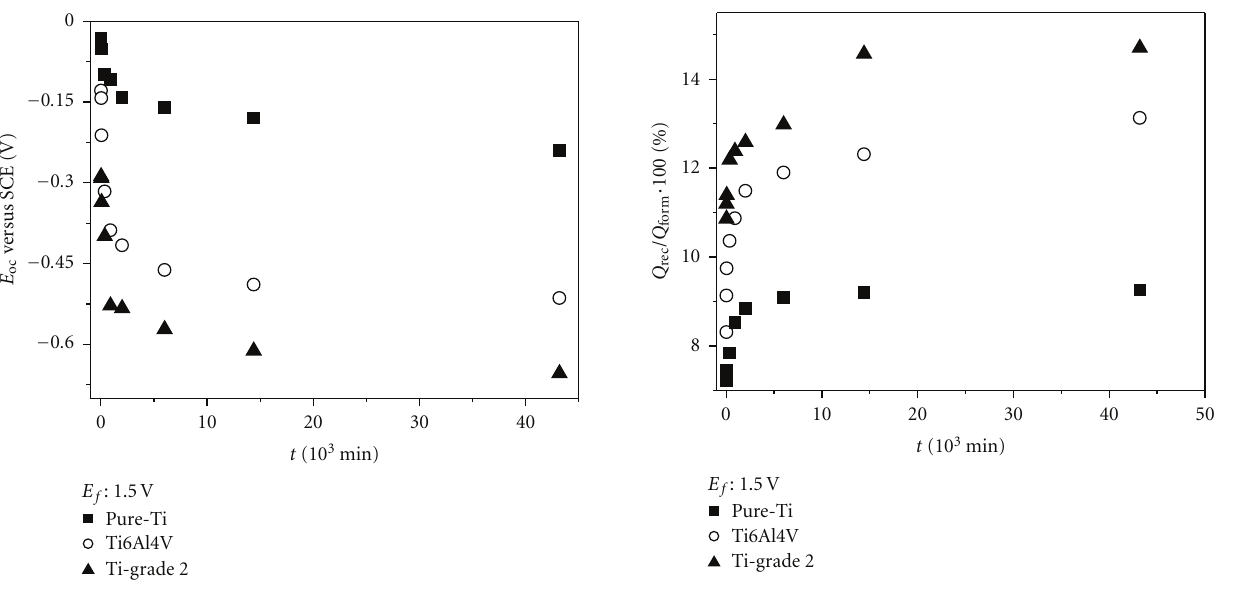
Figure 2: Open-circuit potentials as a function of immersion time, in artificial saliva, for Ti pure, Ti6Al4V, and Ti-grade 2 covered with oxide films potentiodynamically grown up to 1.5V, in PBS solution.